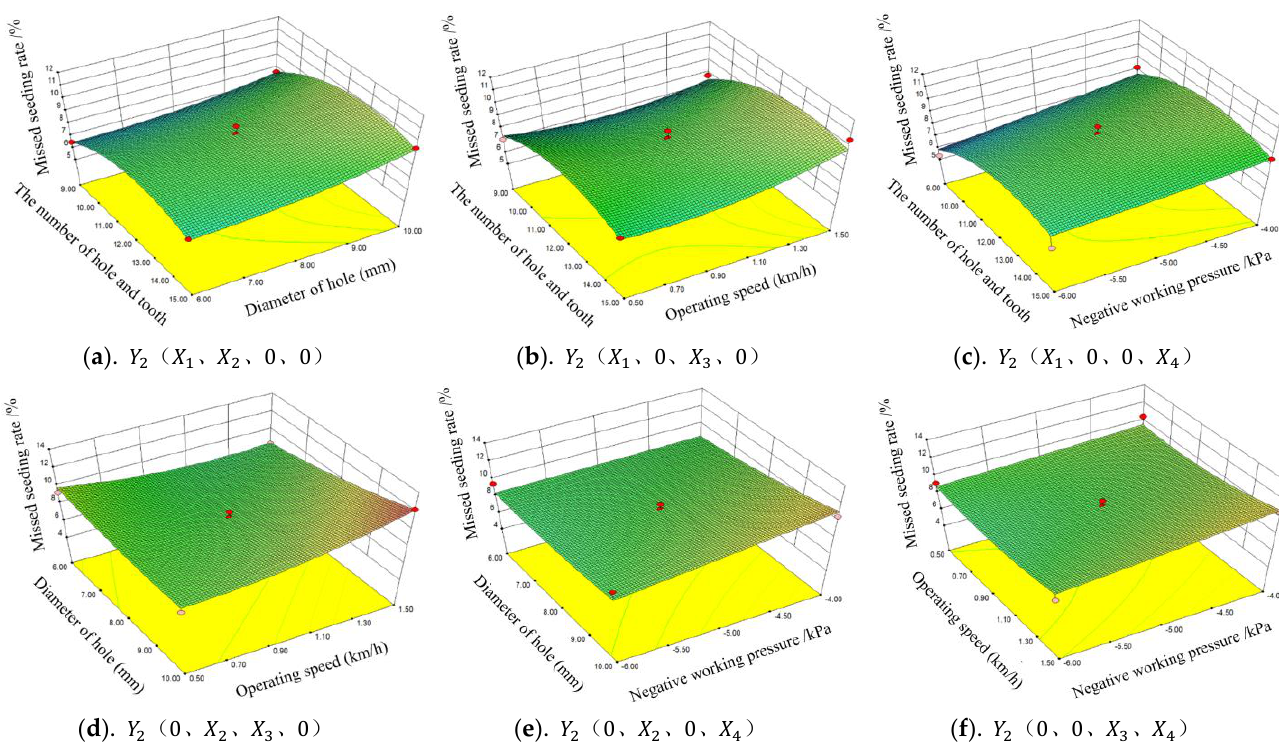
Figure 16. Influence of various factors on miss seeding rate.